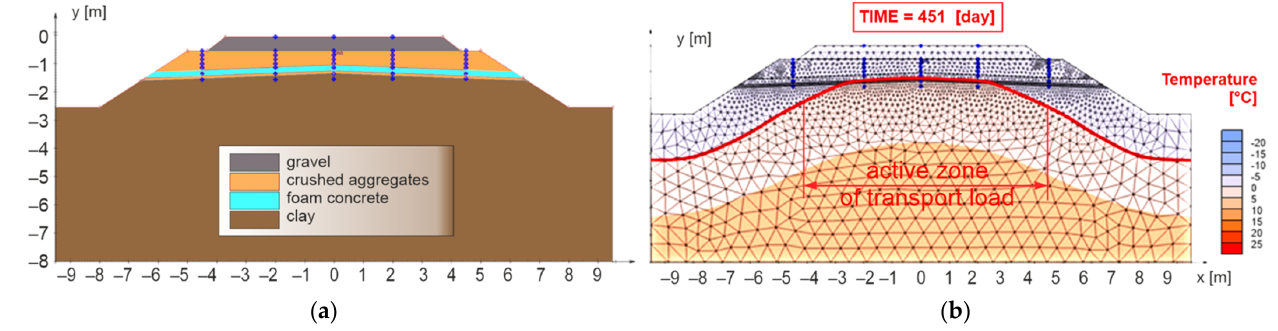
Figure 12. Numerical model No. 2—double-track railway line with horizontal sub-ballast upper surface and with built-in composite layer of FC extended to the whole width of the body of the railway bottom for the applied climate factors I F = 1400 °C, day and θ m = 2 °C ( a ), day of reaching the highest freezing depth of structural layers of the numerical model ( b ).